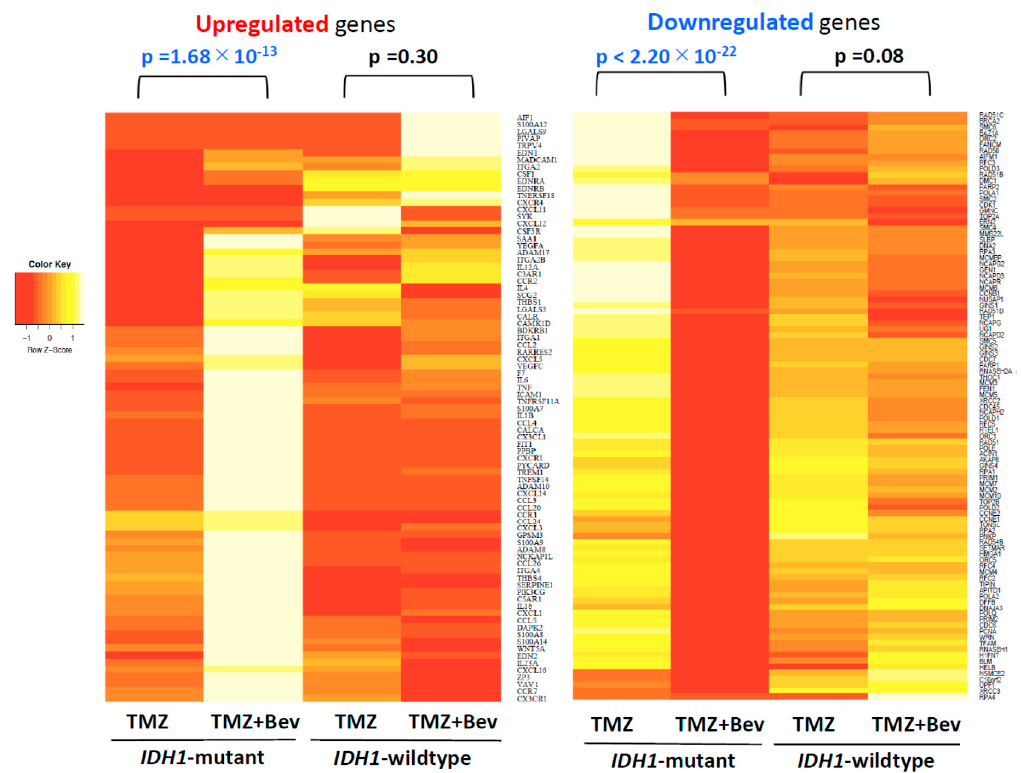
Figure 4. Heatmaps of upregulated genes ( left ) and downregulated genes ( right ) in IDH1 -mutant U87 cells after adding Bevacizumab to Temozolomide. Although the expression level of genes for immunocyte migration or the cell cycle significantly changed in IDH1 -mutant U87 cells, it showed no significant change in IDH1 -wildtype U87 cells.